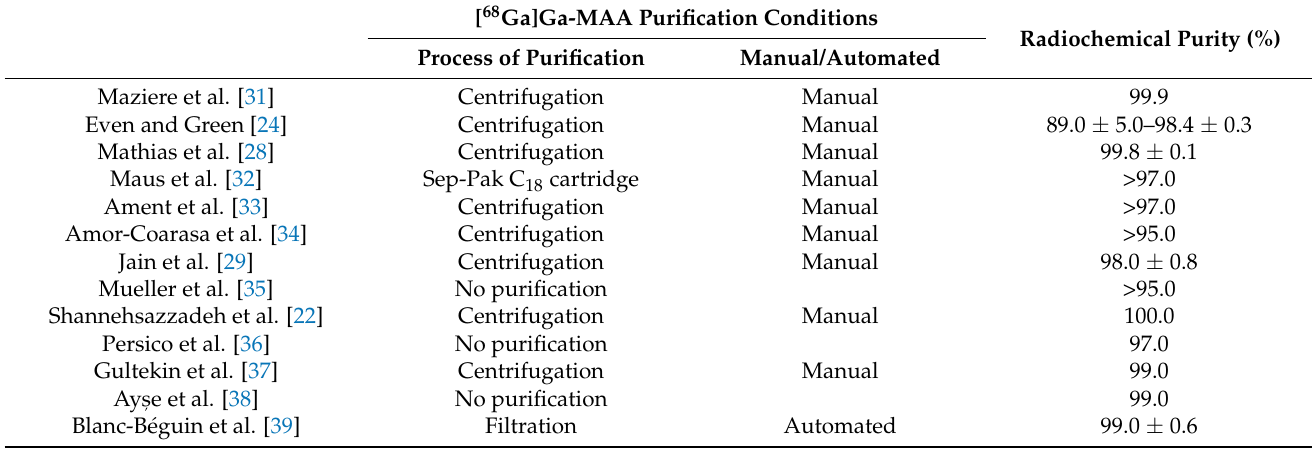
Radiochemical Purity (%)